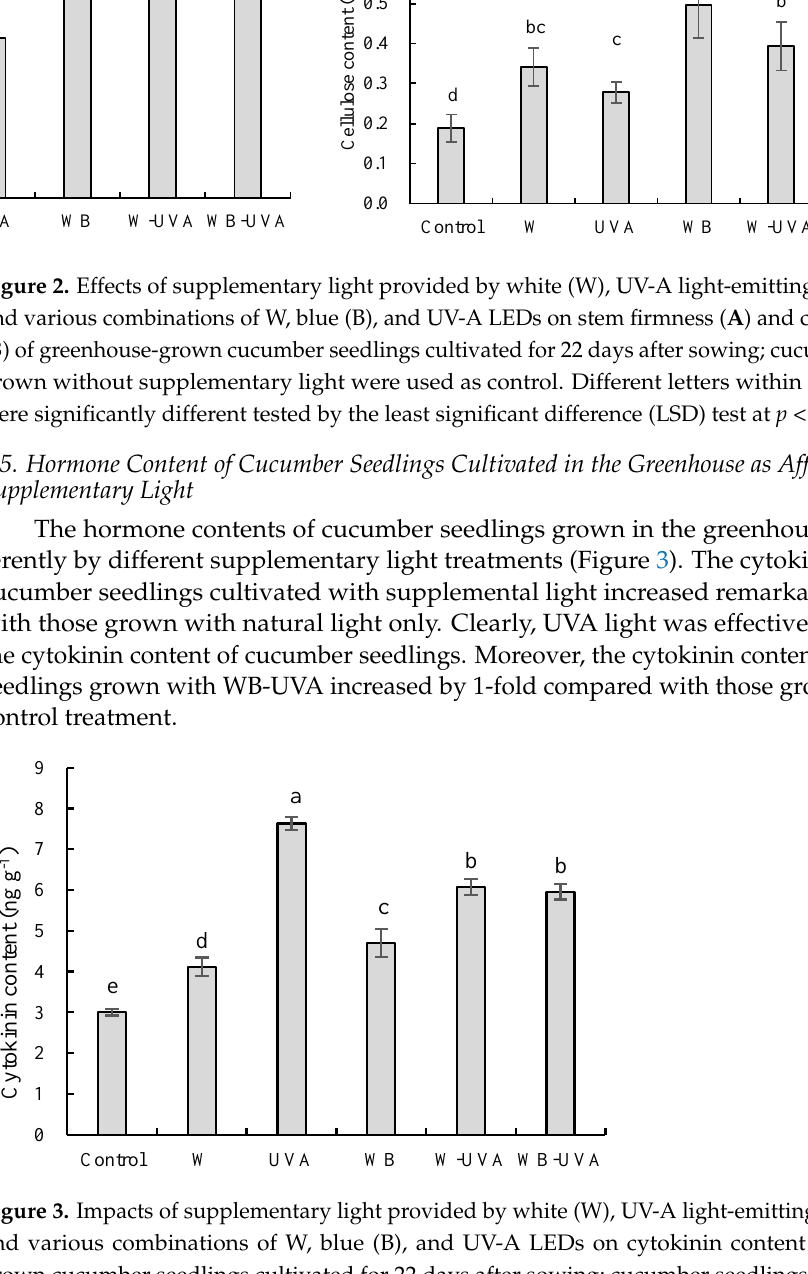
(Figure 2). The stem firmness and cellulose content of cucumber seedlings grown under the combination of white, blue, and UVA light were 1.9- and 2.7-times higher compared with cucumber seedlings grown with supplementary white LEDs, respectively. In addition, UVA light also led to higher stem firmness and cellulose contents of greenhouse-grown cucumber seedlings.